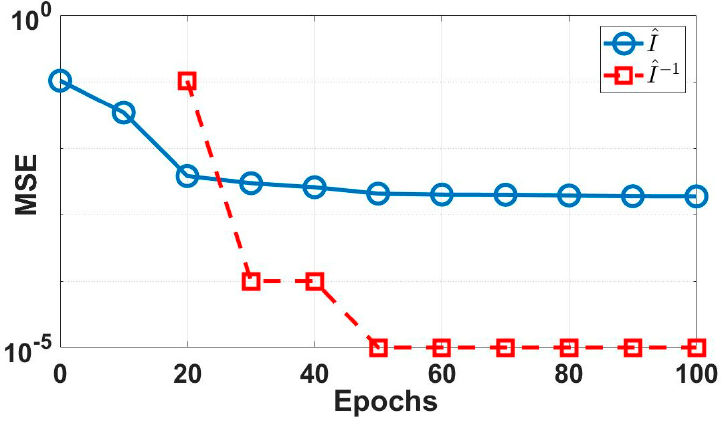
Figure 7. Experimental results for comparison of experimental MSE training loss for the NNs.